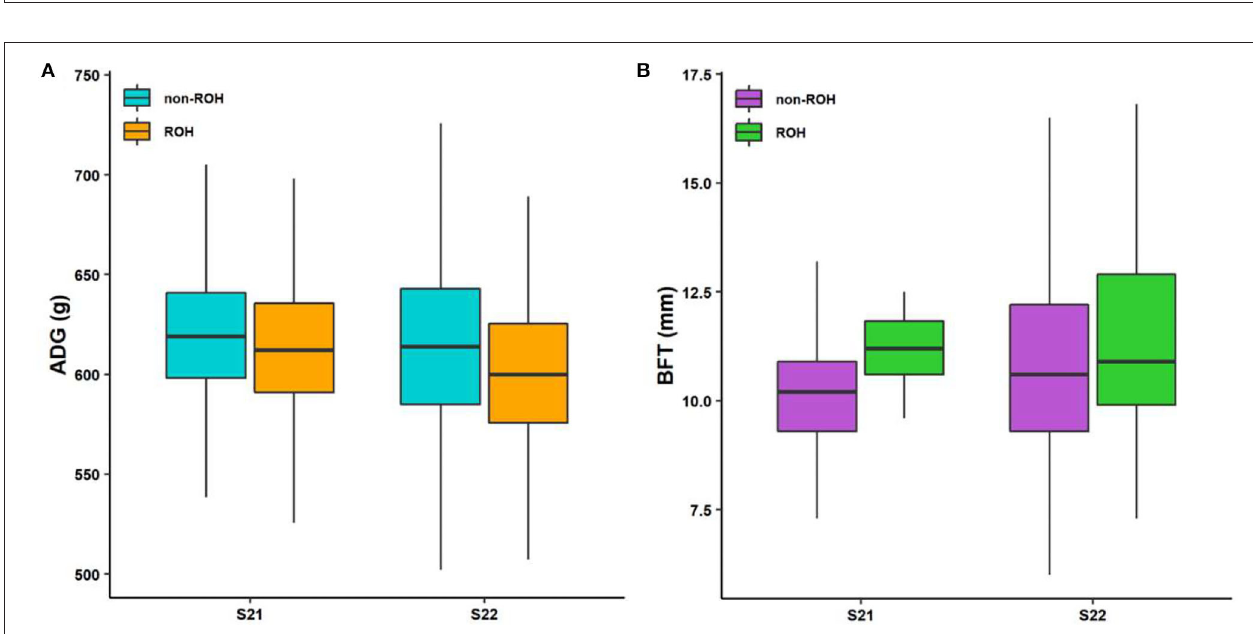
FIGURE 3 | Number of pleiotropic ROHs across economic traits. (A) S21 population. (B) S22 population. S21, Duroc pigs of American origin; S22, Duroc pigs of Canadian origin; ADG, average daily gain at 100kg; BFT, backfat thickness; LMA, loin muscle area; LMP, lean meat percentage at 100kg; and TTN, total teat number. Venn diagrams are plotted using the web server (http://www.ehbio.com/test/venn/) .